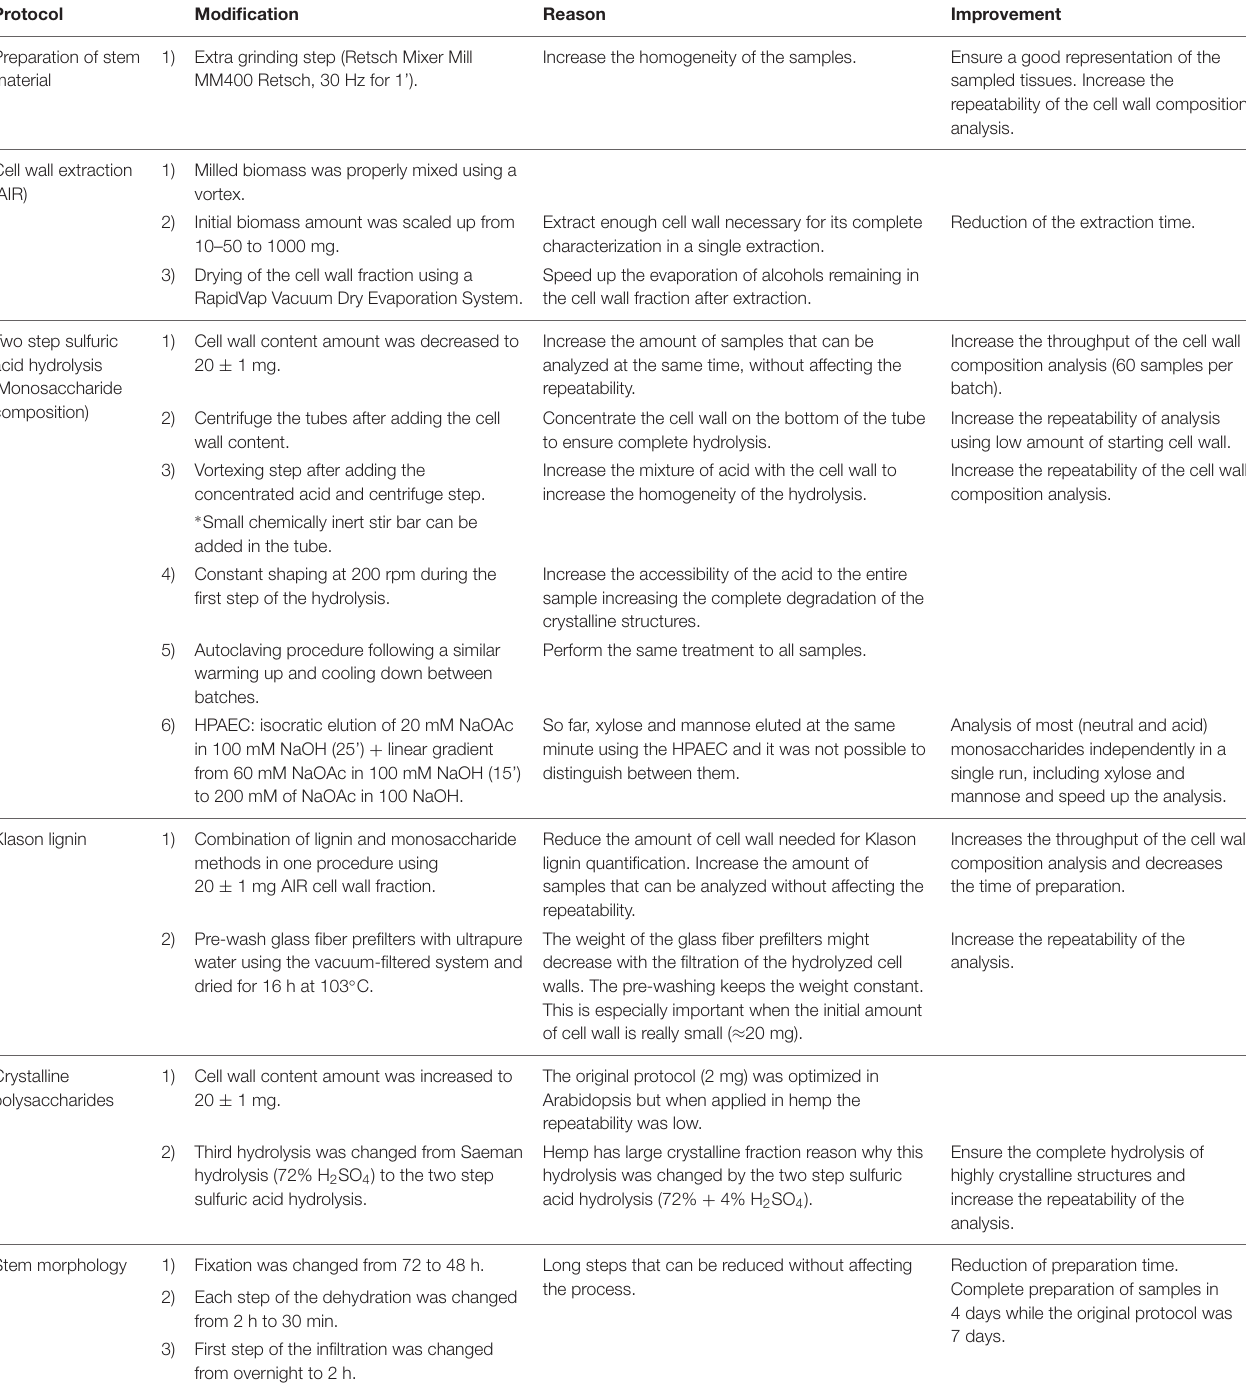
TABLE 2 | Summary of the modifications of the five protocols.